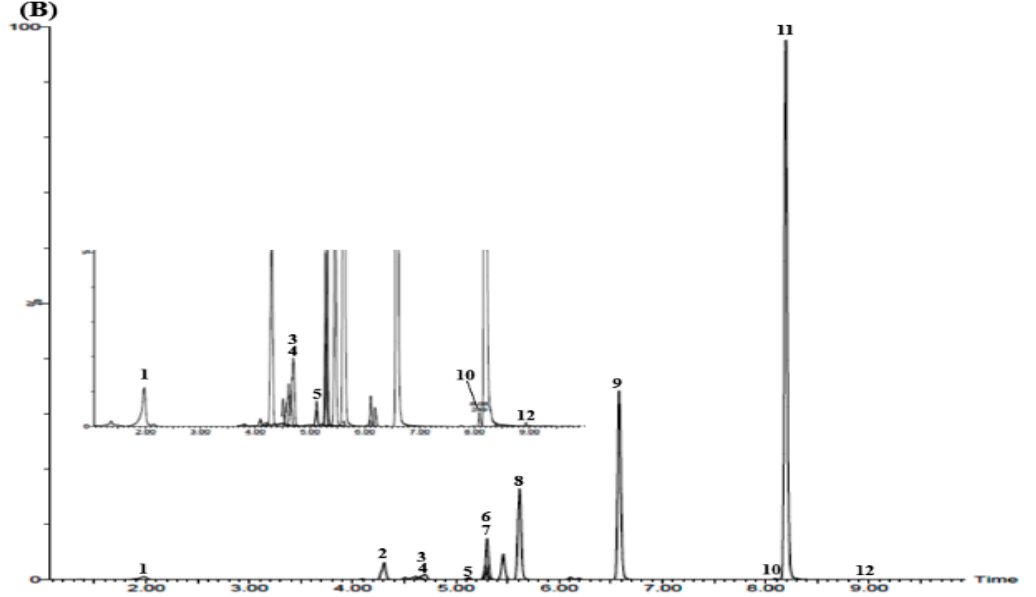
Figure 2. Total ion chromatograms of the reference standard ( A ) and YPS sample ( B ) by UPLC–MS / MS MRM mode. 3-CQA ( 1 ), CFG ( 2 ), FA ( 3 ), LIQA ( 4 ), NAR ( 5 ), 5-MVS ( 6 ), NAG ( 7 ), NHES ( 8 ), OPDH ( 9 ), GA ( 10 ), ARC ( 11 ), and 6-GIN ( 12 ). Table 5. Amount of the 12 marker components in YPS by LC–MS / MS MRM mode (n = 3).